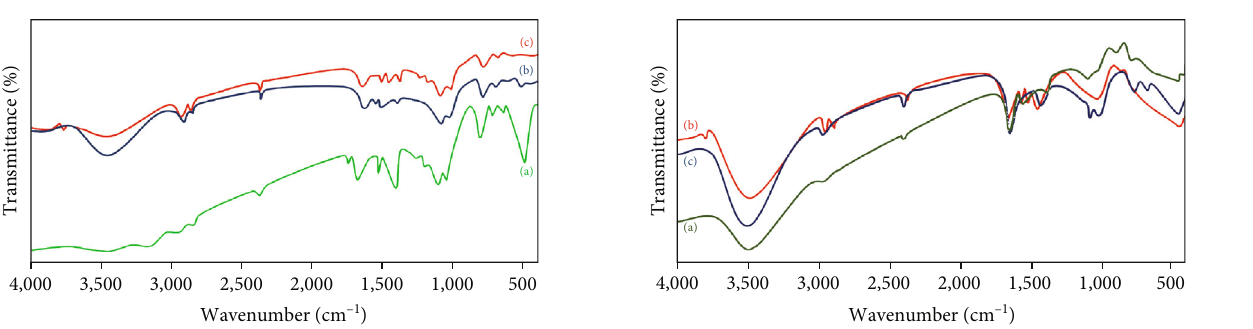
Figure 3: Scanning electron micrographs of virgin epoxy coating (T natural exposure (NIO and KPT) and salt spray testing (SST).